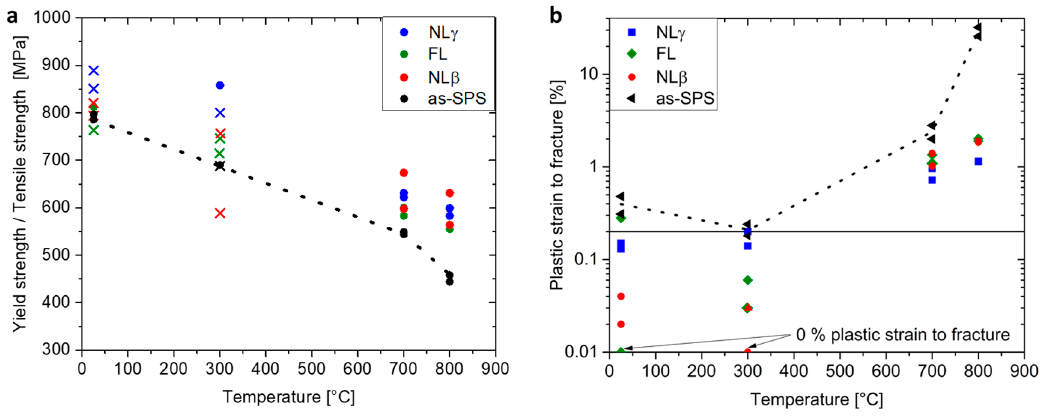
Figure 3. Tensile properties of the investigated material conditions, see Table 2: ( a ) the 0.2%-yield strength is marked with dots, whereas the ultimate tensile strength is denoted with crosses; ( b ) plastic strain to fracture. The 0.2% fracture elongation is indicated as a horizontal line. Two samples failed within the elastic regime. Their values are plotted at the bottom in the logarithmic diagram. The black dashed lines in ( a ) and ( b ) are the baseline provided by the as-SPS condition. For the interpretation of the references to color in this figure legend, the reader is referred to the online version of this article.